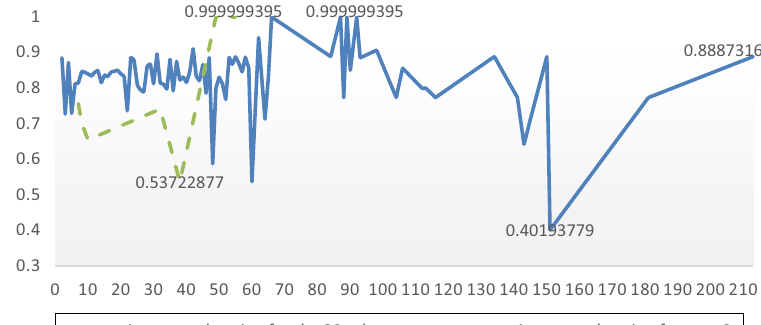
Figure 15. The average toleration for Post 9 as compared to the average toleration for the 20 other posts Average tolera(cid:2)on for the 20 other posts Average tolera(cid:2)on for post